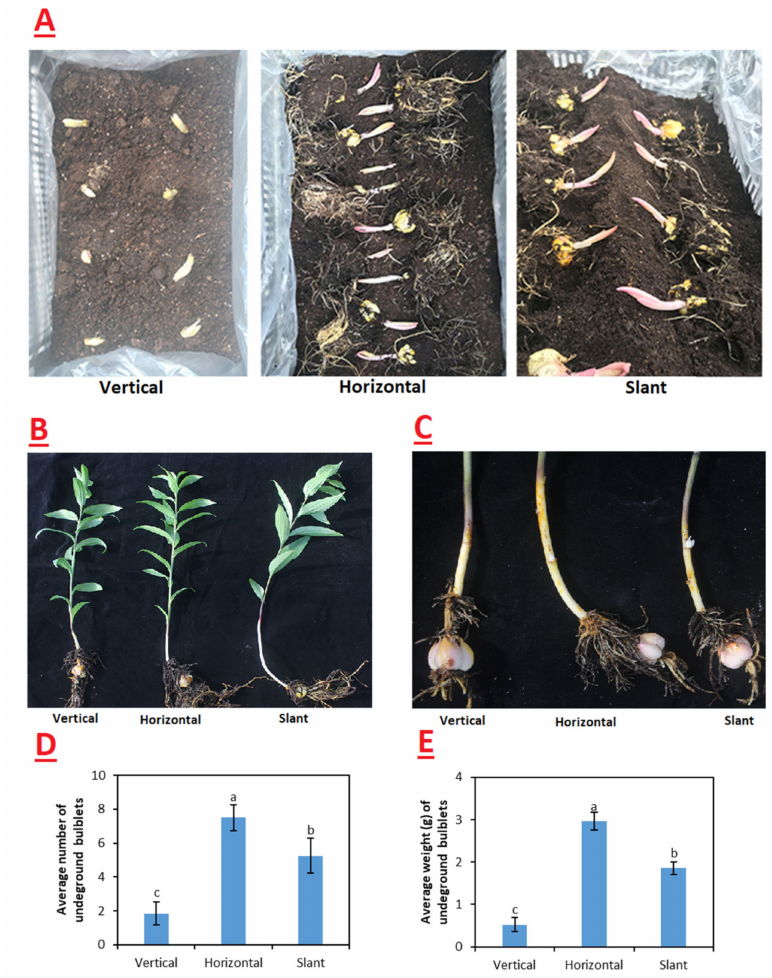
Figure 1. ( A ) Three different bulb planting patterns adopted in the study. ( B ) The growth of whole plants at stage A (20 days after planting). ( C ) The growth of underground stems at stage B (50 days after planting). ( D ) The average number of underground bulblets (20 plants per group). ( E ) Average weight of underground bulblets (20 plants per group). Lowercase letters indicate significance among treatment groups according to Duncan’s multiple range test at p <